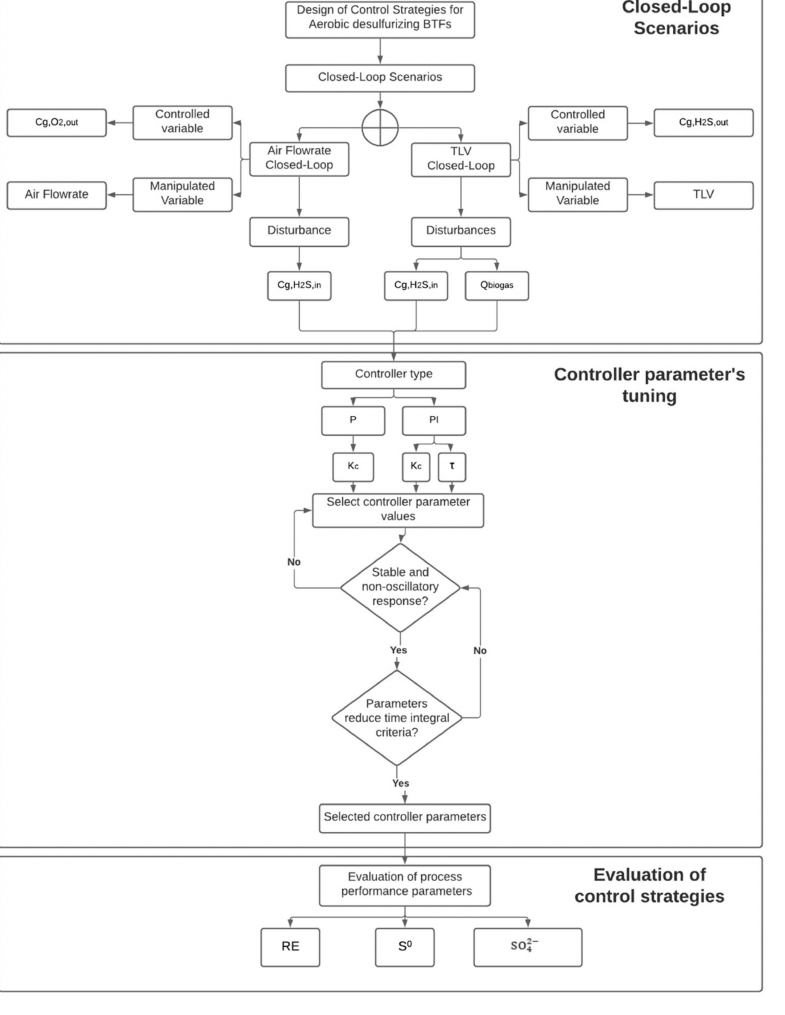
Figure A1. Flowchart of the methodology followed for feedback control strategies